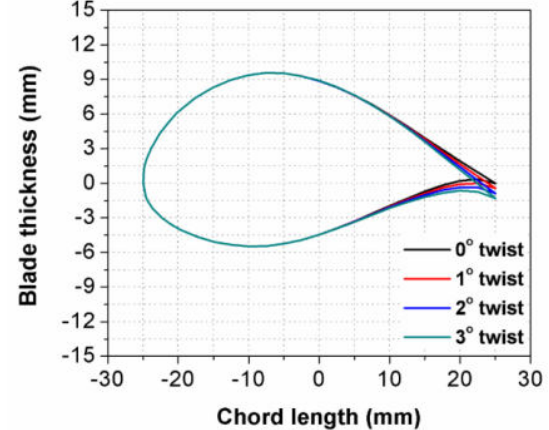
Figure 7. Airfoil twist angles used for present 2D numerical simulation.